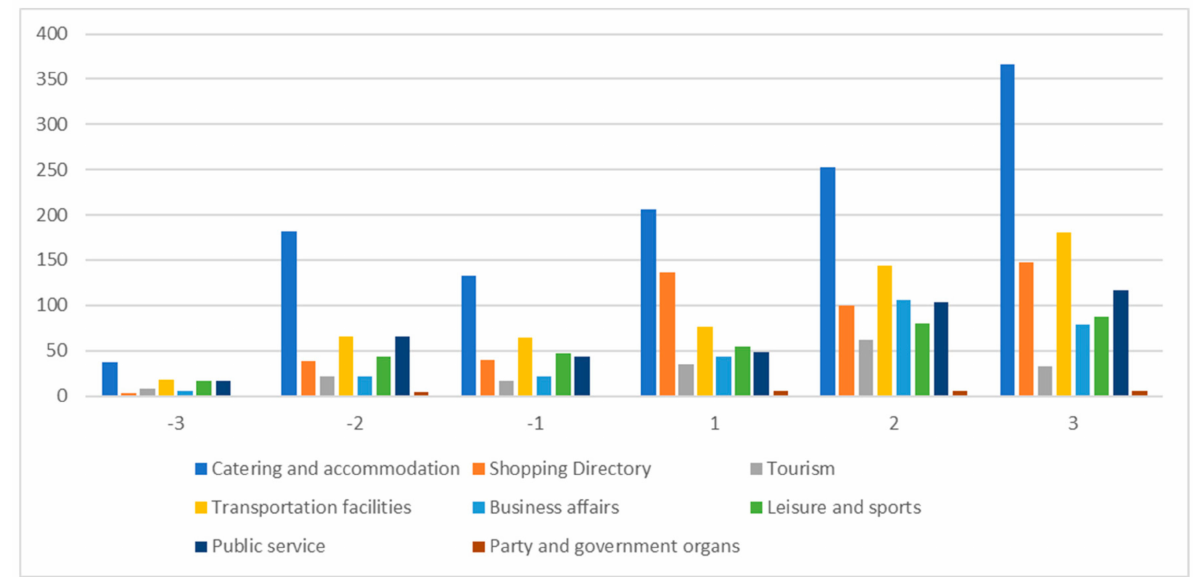
Figure 18. Quantity comparison of the POI dataset contained by hot/cold spots